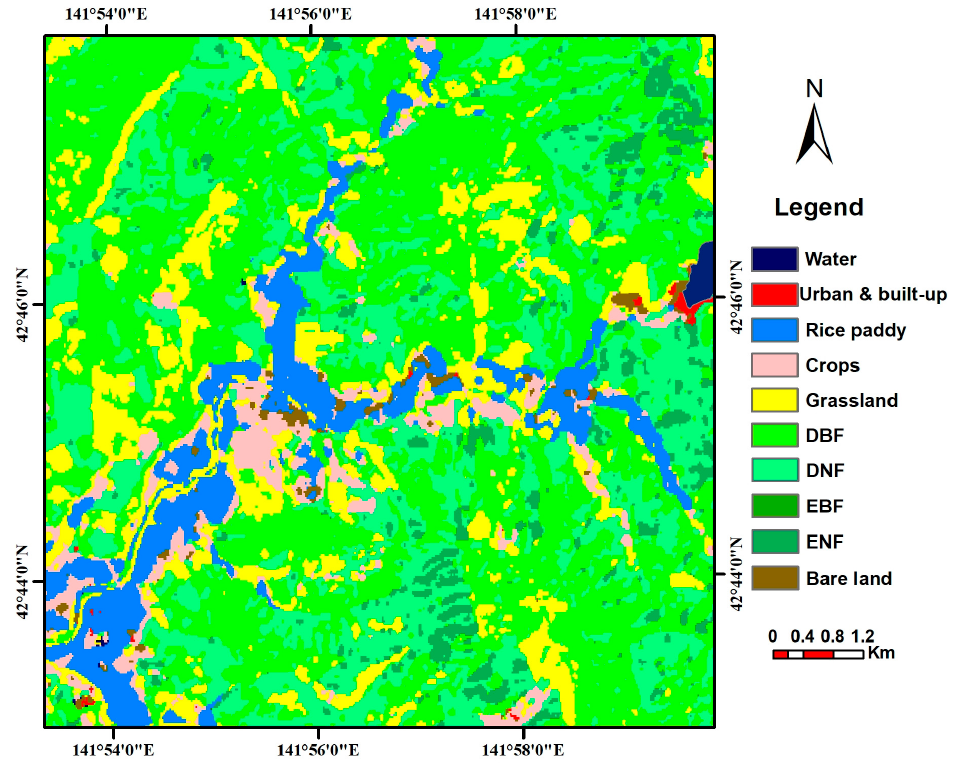
Figure 3. The land use and land cover maps of the study area. The data were provided by JAXA and are available at https://www.eorc.jaxa.jp/ALOS/en/lulc/lulc_index.htm.